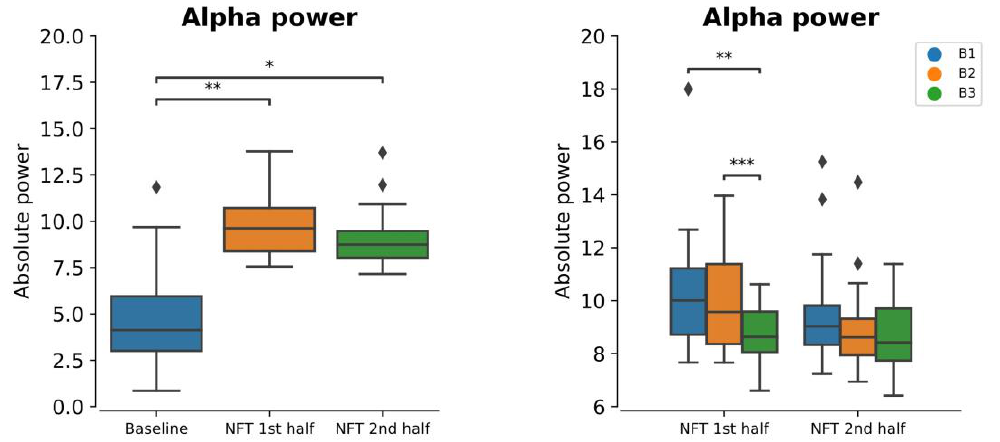
Figure 4. Absolute alpha power at baseline and within-session (1st half = first 15 min, 2nd half = last 15 min) and within-session (first half and second half) sub-blocks (B1, B2, and B3, each five minutes) (* p < 0.05, ** p < 0.005, *** p < 0.0005). The diamond shape in the box plots represents the outliers in the data.